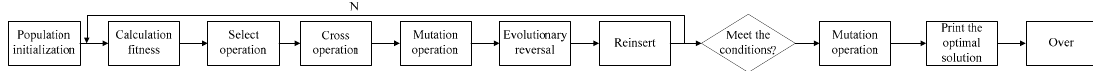
Figure 2. Flow chart of the genetic algorithm for realizing safe person–job matching.